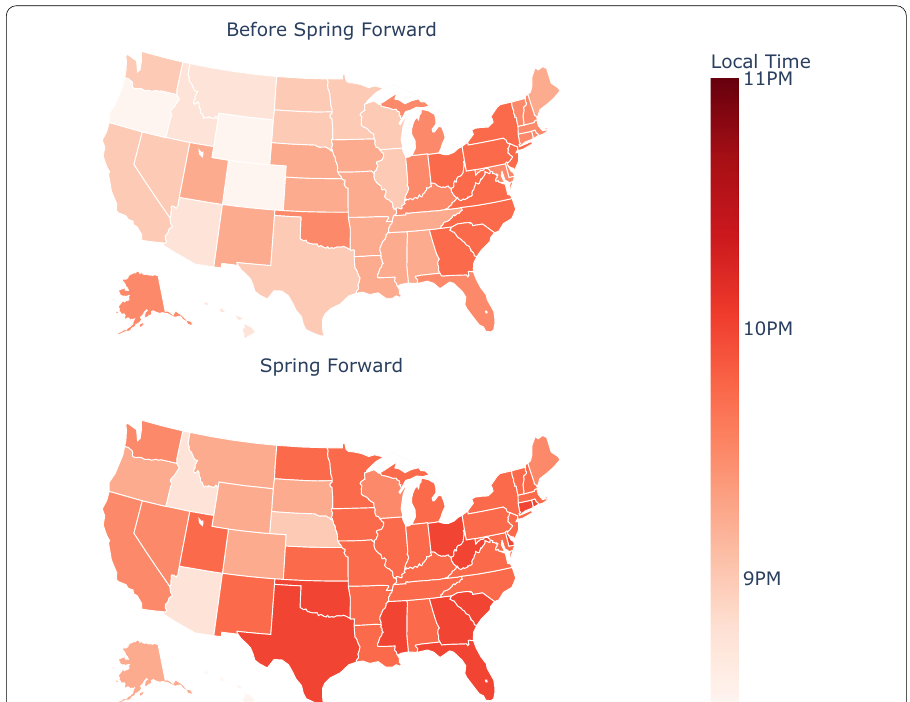
Fig. 3 Time of peak Twitter activity on Sunday night for each state before (top) and the week of (bottom) Spring Forward for the four events observed between 2011 and 2014. Before Spring Forward (BSF), the time of peak activity occurs around 10 p.m. most states in the Eastern Time Zone, and around 9:15–9:30 p.m. for most of the other states. The week of Spring Forward (SF), peak Twitter activity occurs between 0 and 60 min later for each state, with the exception of Alaska, Nebraska, and Hawaii for which the peak occurred earlier. Texas has the latest peak at 10:15 p.m. local time, a shift of 60 min forward compared with prior Sundays. We note again that the BSF estimates are based on the aggregation of four Sundays prior to Spring Forward, while the SF estimates are based on the Sunday coincident with Spring Forward, and are therefore estimated using roughly 1/4 of the data.